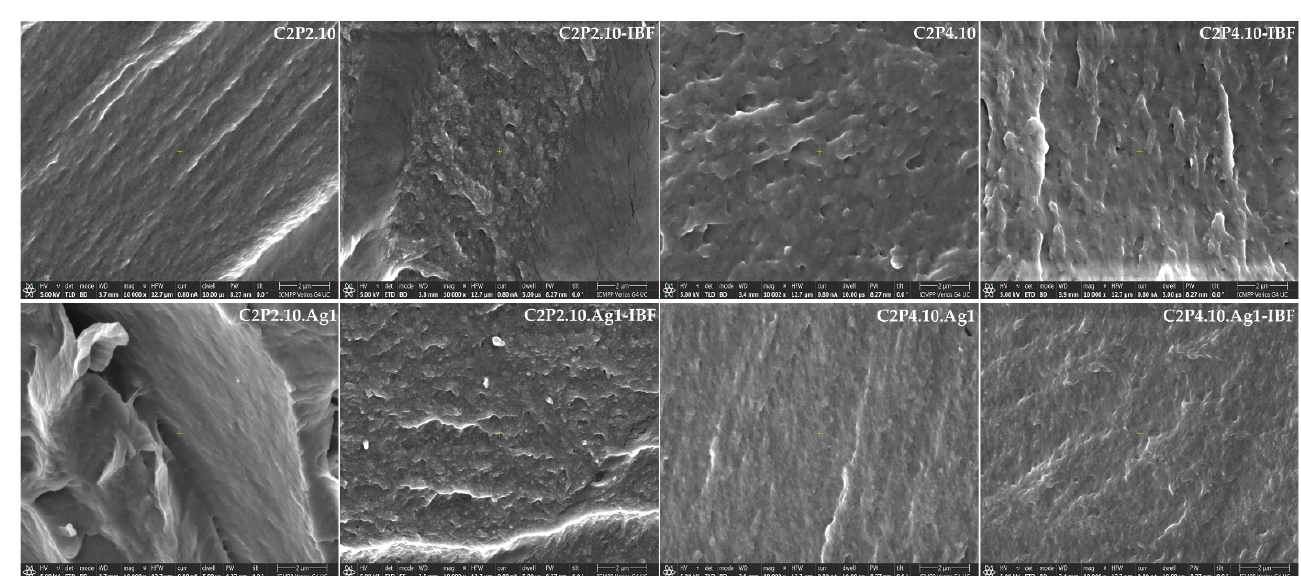
Figure 4. FT-IR spectra for films type C2P4.